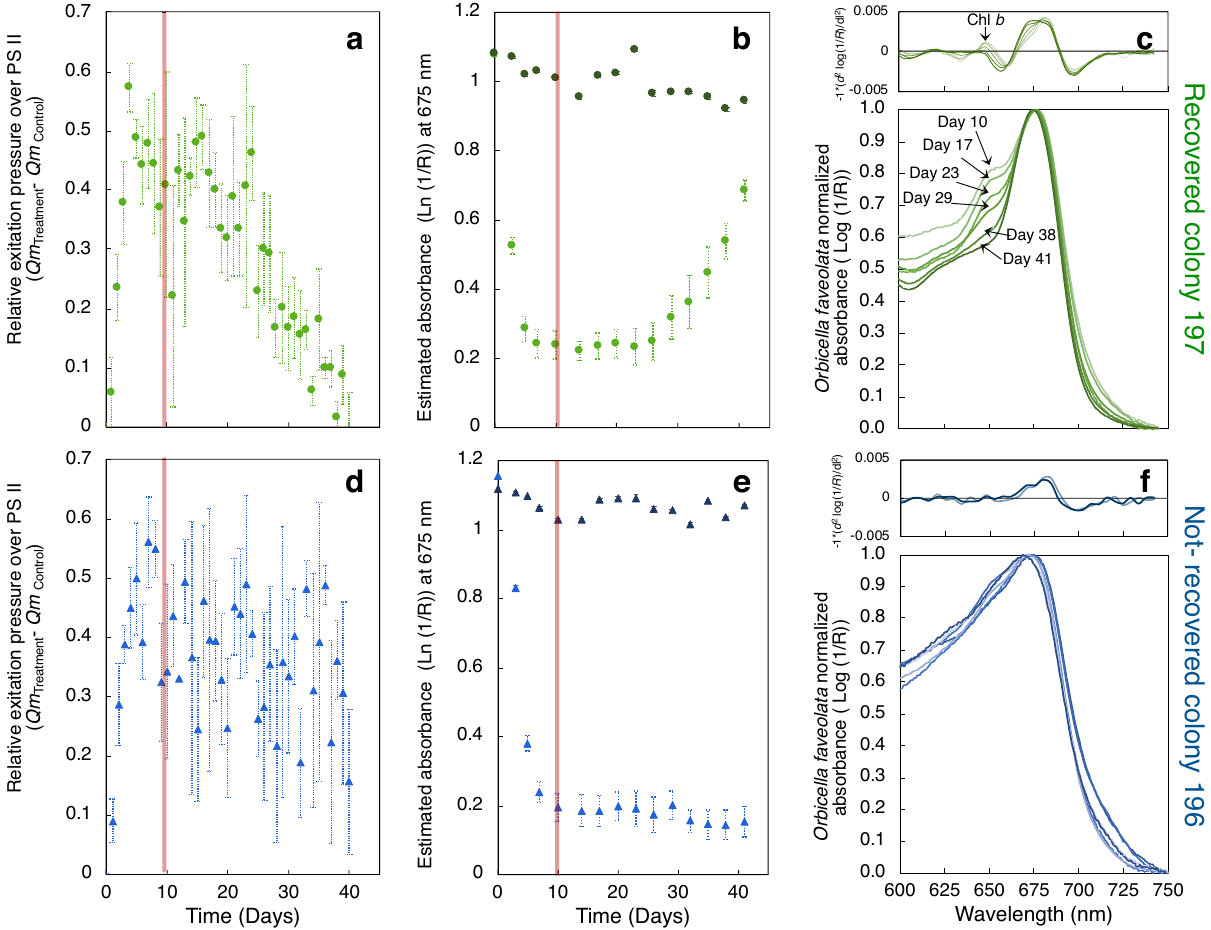
Figure 3. Variation in the physiological parameters and spectroscopic optical properties of Orbicella faveolata coral fragments, during the bleaching and recovery experiment (B-Re). Plots ( a , d ) illustrate changes (Average ± SE) in the relative excitation pressure over photosystem II (Δ Q m = Q m treatment − Q m control ) in: ( a ) colony 197 fragments (n = 37); and ( d ) colony 196 fragments (n = 37). Red vertical solid line represents the end of the heat stress period. Plots ( b , e ) compare the estimated absorbance ( D e = Ln (1/ R )) at 675 nm ( D e675 , Average ± SE), during the B-Re experiment, in: ( b ) colony 197 fragments; and ( e ) colony 196 fragments. Light colored symbols represent heat-stressed corals (n = 18), and dark colored symbols represent control corals (n = 19). Red vertical solid line indicates the end of the heat stress period. Plots ( c , f ) describe the variation in the average absorption spectra of: ( c ) colony 197 fragments; and ( f ) colony 196 fragments; on the last day of the heat stress treatment (32 °C, day 10, light green line and light blue line respectively), and during the recovery period (28 °C, days 11 to 41, dark green line and dark blue line respectively). Spectra were normalized to the maximum peak of absorption of Chl a . Top panels represent the second-derivative analysis of the light absorption